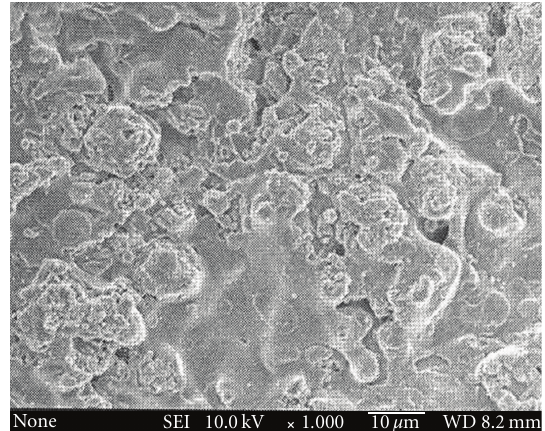
Figure 4: Surface of the sprayed nanotitanium dioxide coating